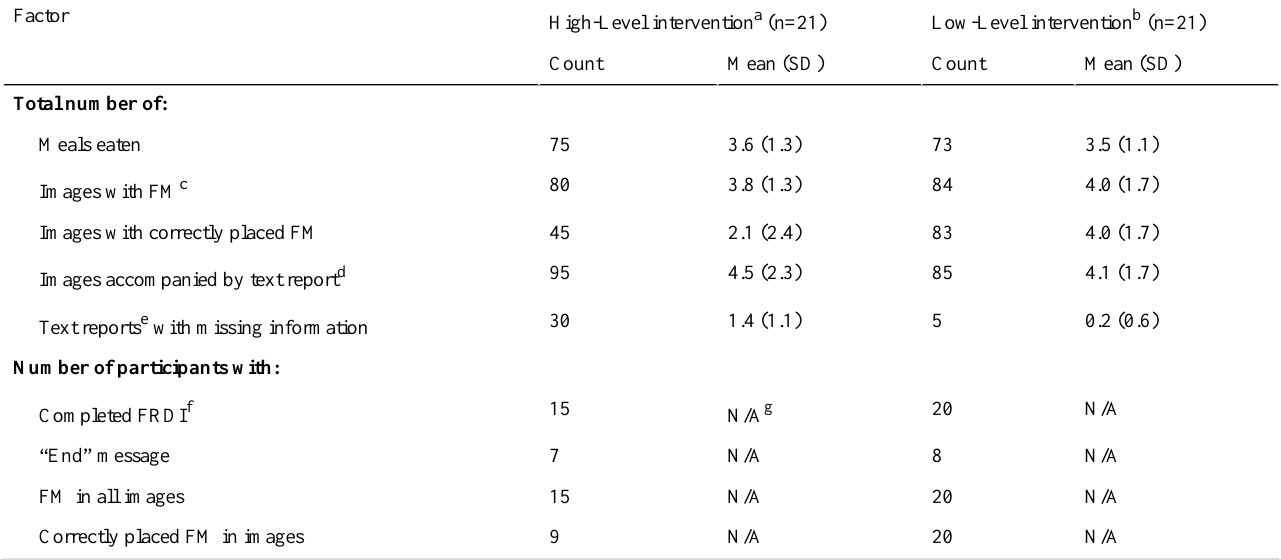
Table 2. Assessment of the 1-day food record with digital images, by group.